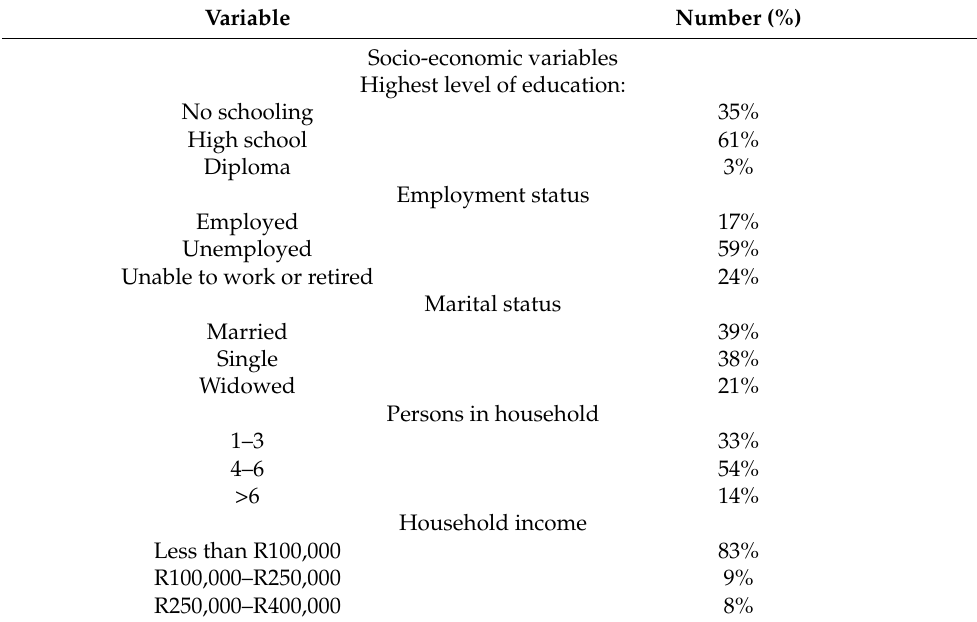
Table 1. Characteristics of study